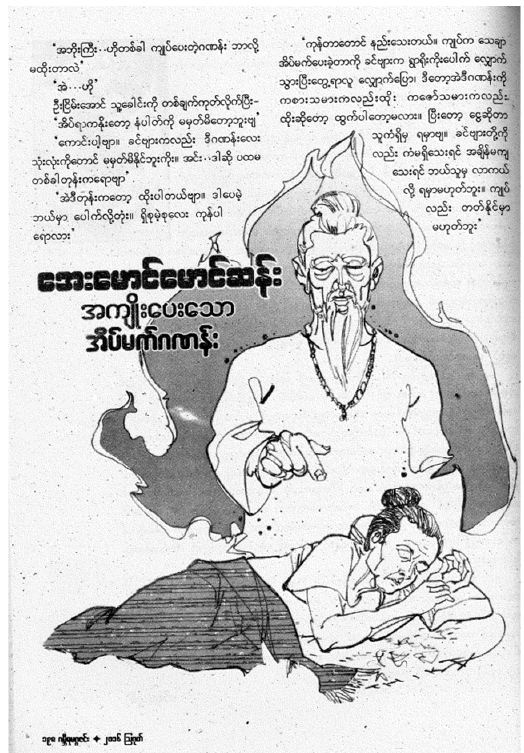
Figure 2. Another example of a dream account published in a popular Burmese Buddhist magazine. ( Gambhira maggaja ṅ ʻ ʺ August 2016).